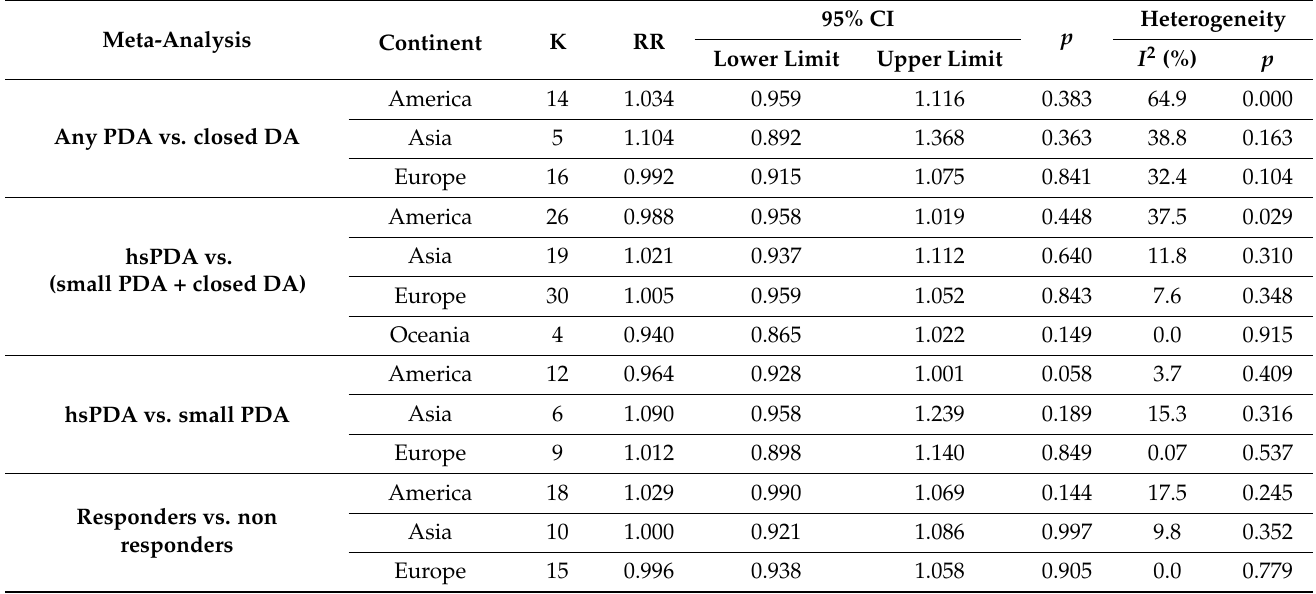
Table 3. Subgroup analysis based on